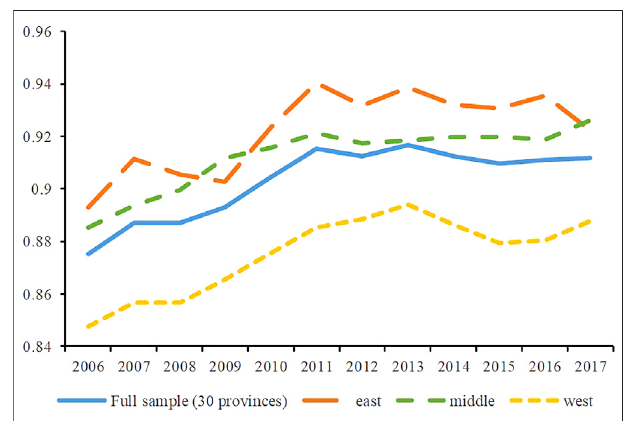
FIGURE 4 | The average value of UEIi in different